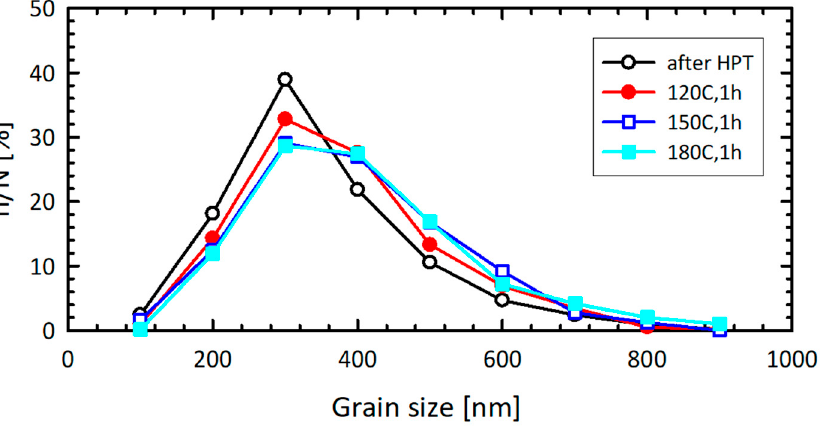
Figure 1. Grain size distributions of the UFG 6060 alloy after annealing at 120 °C, 150 °C and 180 °C for an hour.